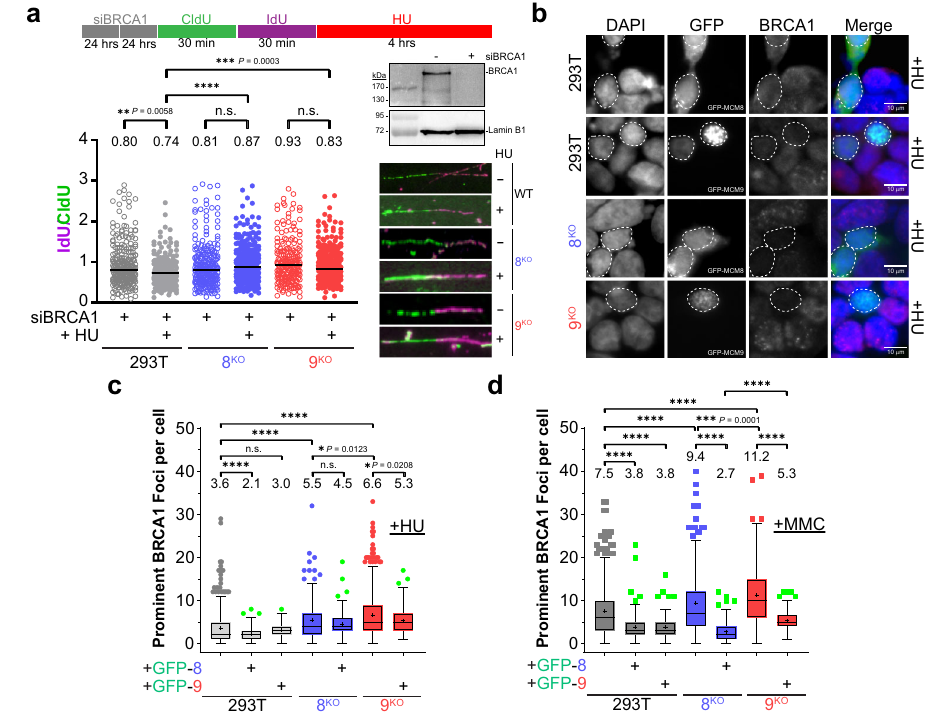
Fig. 6 | BRCA1 functions with and is dependent on MCM8/9 to maintain repli- cation fork integrity. a 293T WT (gray), 8 KO (blue), or 9 KO (red) cells were trans- fectedwithsiRNAtwicefor24heachtoknockdownBRCA1andveri fi edbywestern blot. Cells were then sequentially incubated with CldU and IdU for the indicated timeintervals( ○ )orfollowedby2mMHUfor4h( ● ).DNAwasspreadbygravityto measure NSD by quantifying IdU and CldU lengths using Image J (>200 fi bers). Representative fi bers are shown to the right of the dot plots. The corresponding median ratios are reported at the top of the plots and by a black line embedded in the data. A Mann – Whitney two-sided U test was used to calculate P values (n.s. nonsigni fi cant, * P <0.05, ** P <0.01, *** P <0.001, **** P <0.0001). b GFP-MCM8 or GFP-MCM9 was transfected into each cell line and treated with 2mM HU for 4h ( n =2 independent experiments). Dashed white outlines of nuclei indicate cells successfully transfected and show a decrease in BRCA1 signal and foci. Larger replicationforkhelicasecomplexresultedincontinuedreplicationand